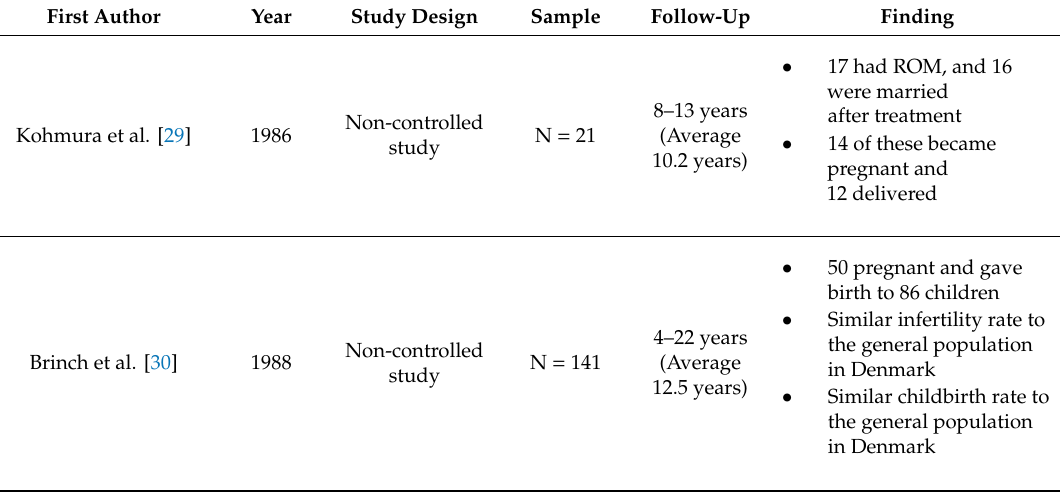
Table 1. Studies included in the systematic